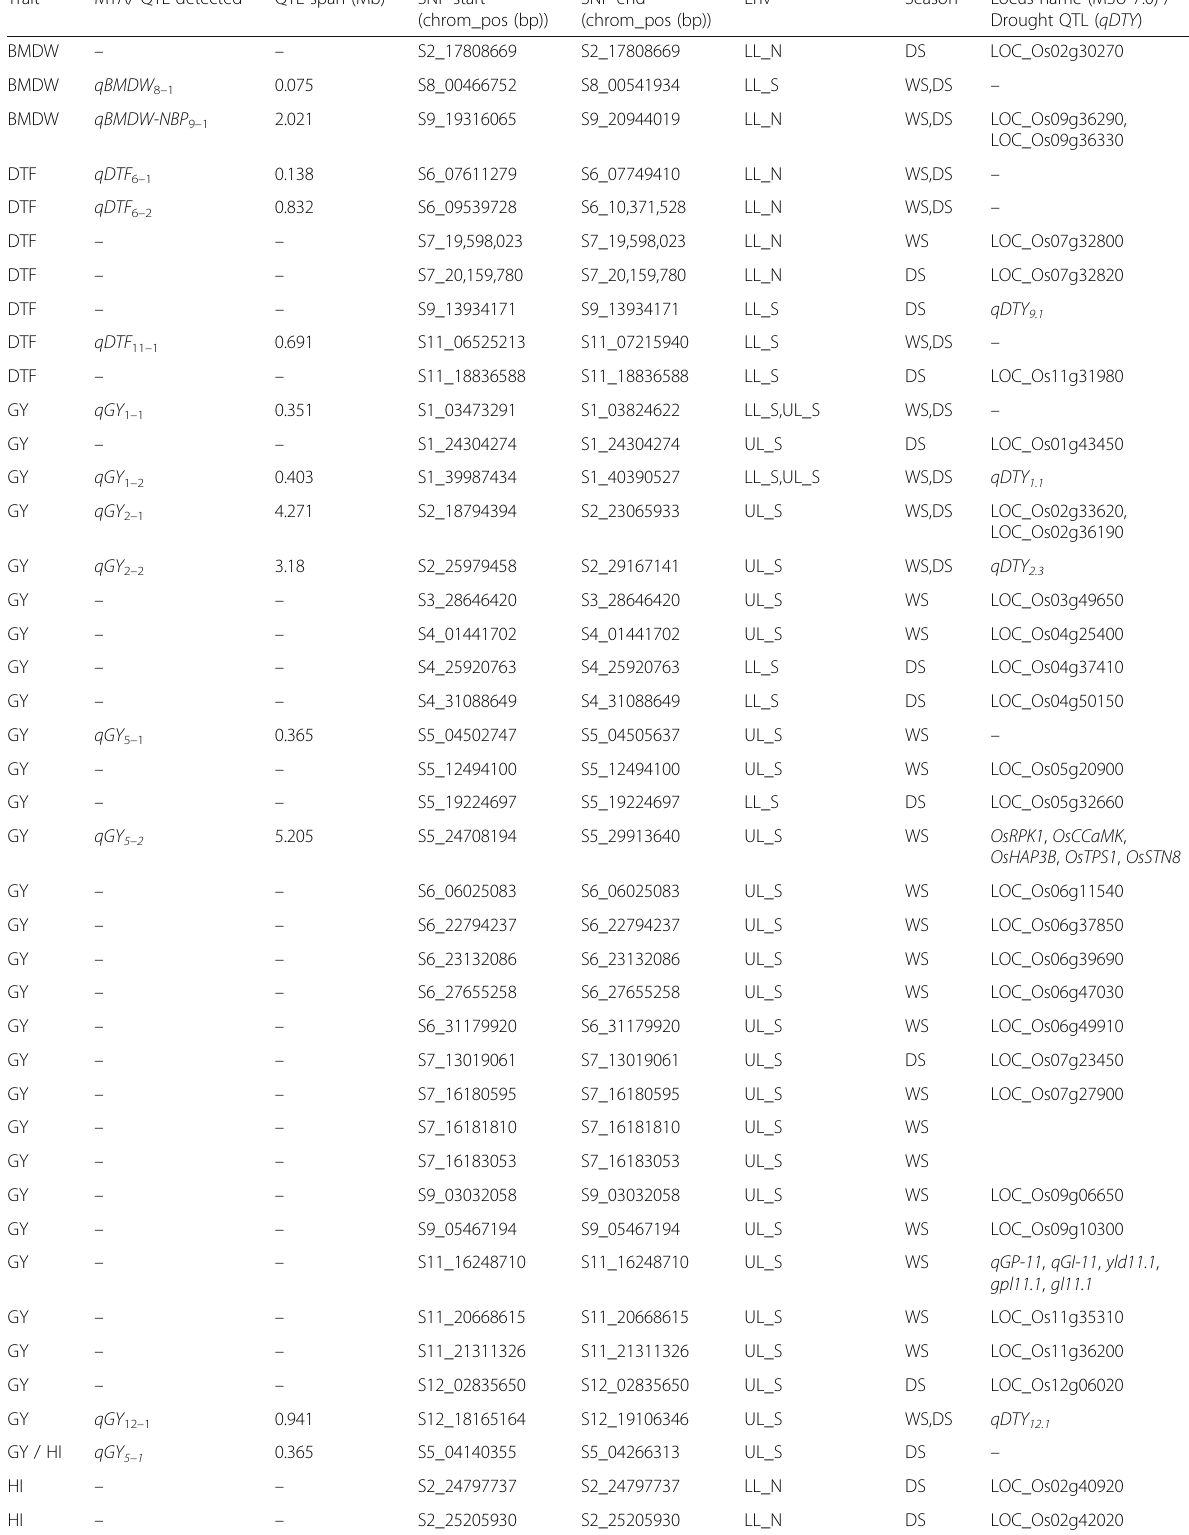
Table 3 Summary of candidate gene analysis for seven traits in different seasons and environments validated for genes and qDTY